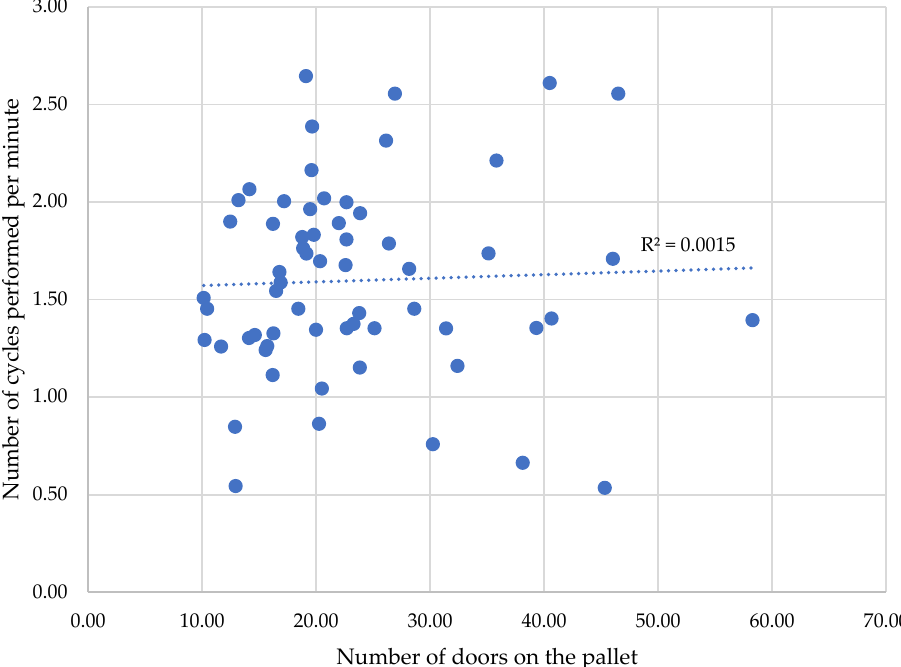
Figure 10. Dependence of the number of cycles performed per minute on the number of doors on the pallet.